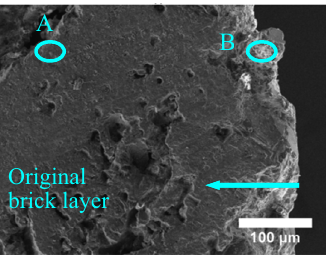
Figure 10: SEM picture of cross section at 1/2 height of MgO – CaO refractory.